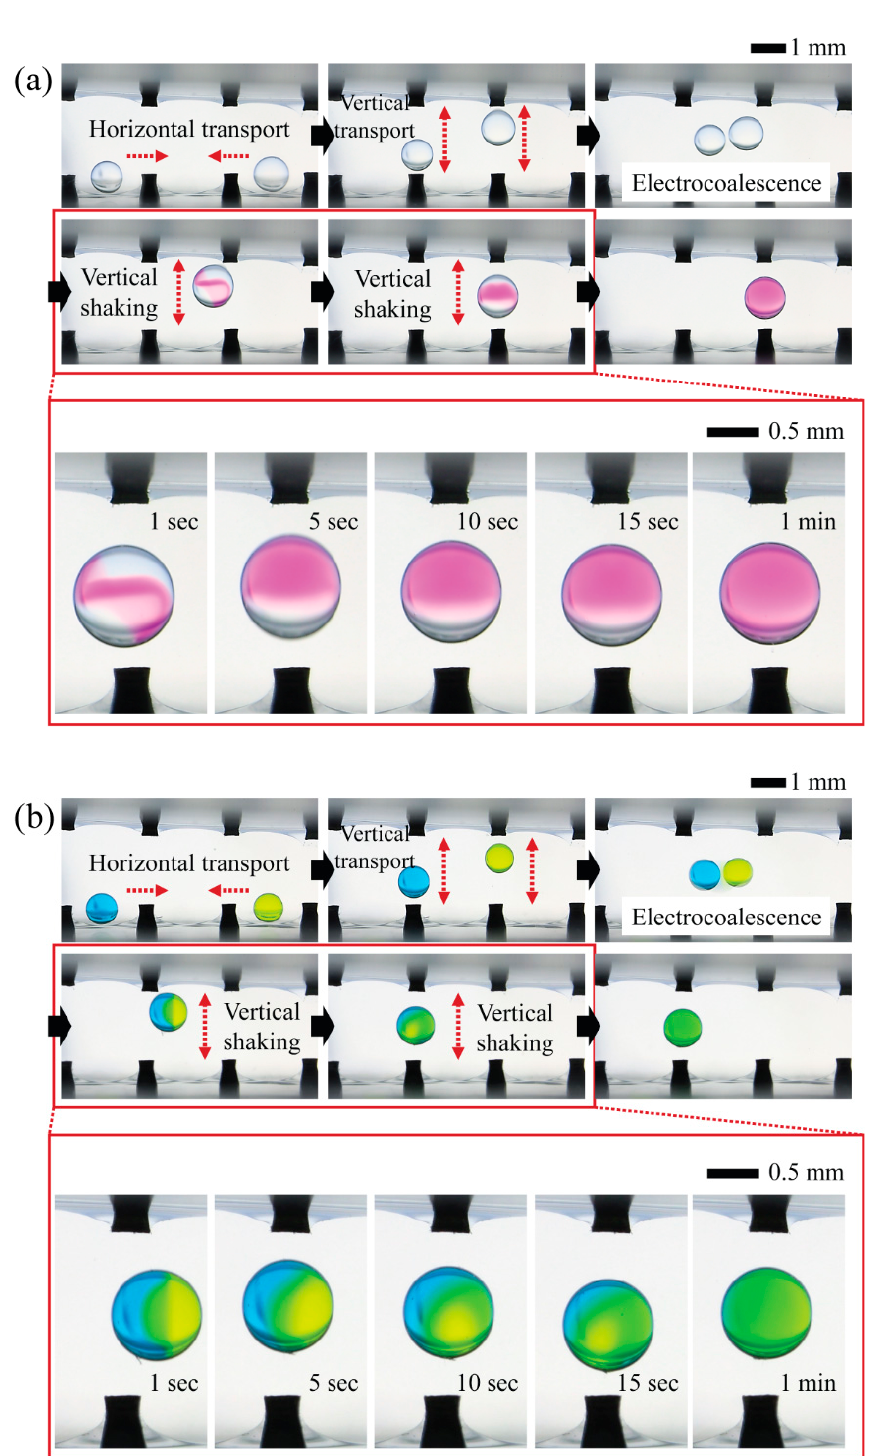
Figure 5. Programmable droplet handling procedure, including horizontal and vertical transport of two oppositely charged microdroplets containing different chemicals, merging via electrical interaction, and vertical shaking via vertical reciprocating motion. ( a ) Mixing between a droplet of PHP indicator solution (left) and a droplet of sodium hydroxide aqueous solution (right) (Video S3 in Supplementary Materials). ( b ) Mixing between a blue dye droplet (left) and a yellow dye droplet (right) (Video S4 in Supplementary Materials). The distance between the pin electrodes is 2 mm in this case, and the applied voltage is 400 V.